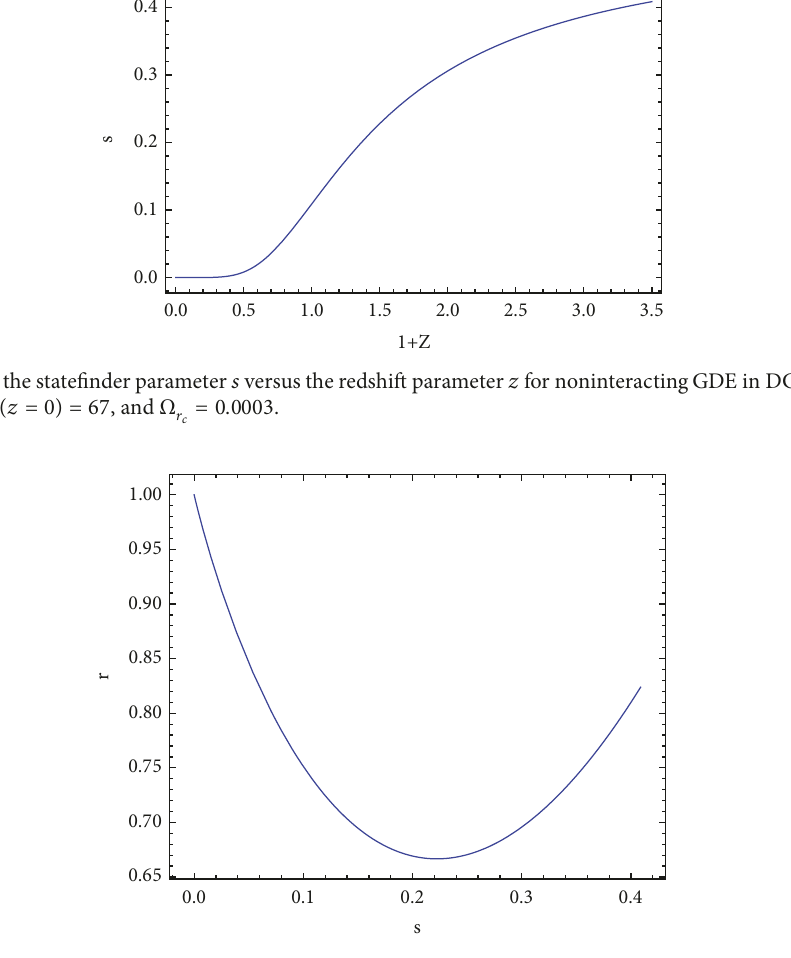
Figure 7: The evolution of the statefinder parameter 𝑟 versus 𝑠 for noninteracting GDE in the DGP model. Here, we have taken Ω 𝐷 (𝑧 = 0) = 0.73 , 𝐻(𝑧 = 0) = 67 , and Ω = 0.0003. 𝑟 𝑐